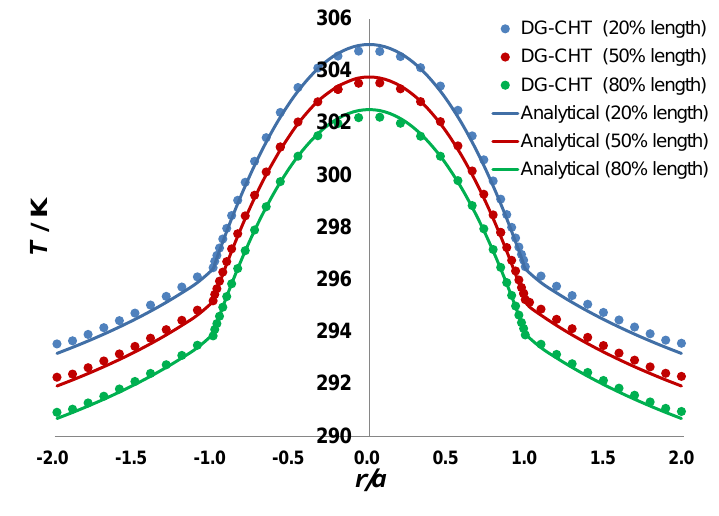
Figure 7. Comparison of temperature distributions of the pipe